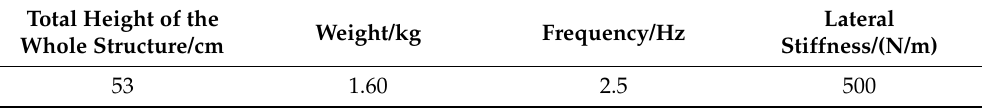
Table 1. Structural dynamic